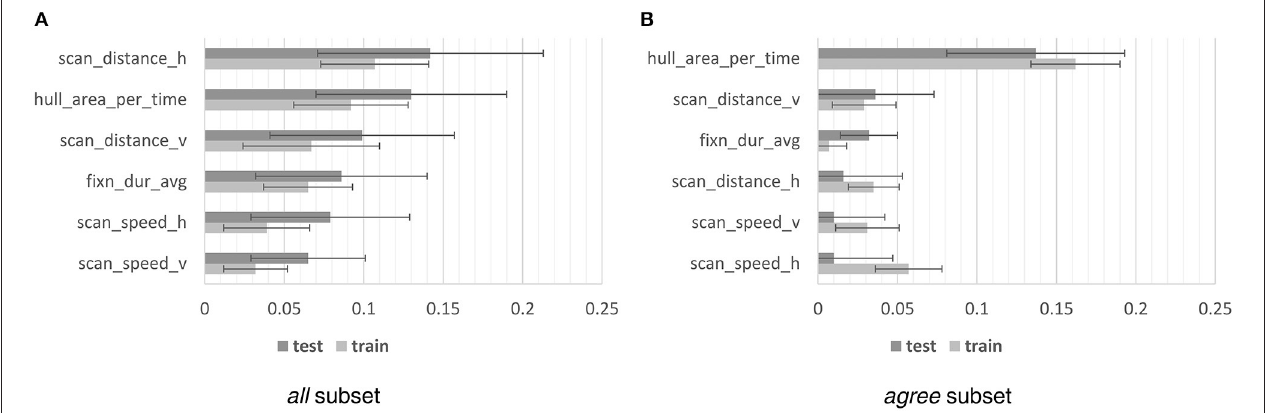
FIGURE 5 | Permutation feature importance in terms of the f1 loss for the all subset (A) and the agree subset (B) of the g-REL data. We show the mean loss in f1 scores from 30 permutation iterations ± the standard deviation. We include the feature importance estimates for the train and test